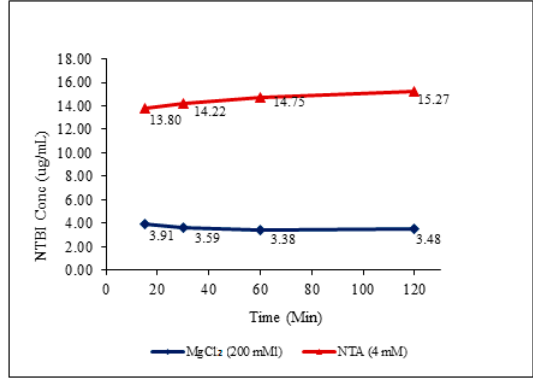
Figure 2. Chelation effects of nitrilotriacetic acid (NTA) and MgCl 2 on Iron colloidal drug with time.